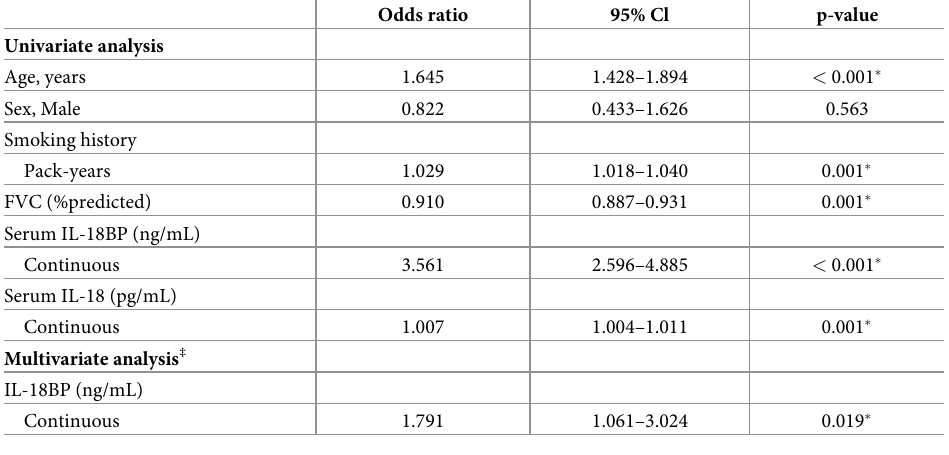
Table 2. Logistic regression analysis of variables associated with the discriminating ability of IPF patients or healthy volunteers.